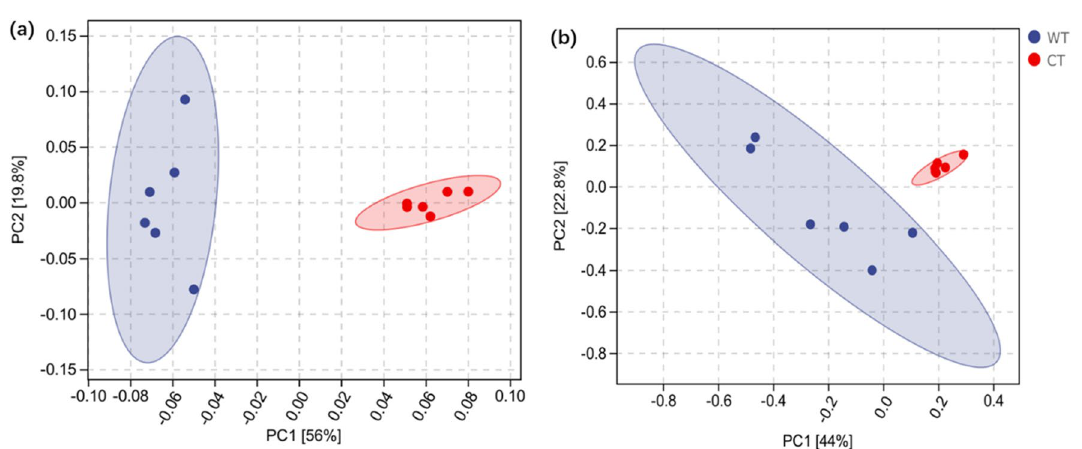
Figure 4. Beta diversity analysis of ( a ) bacteria and ( b ) fungi communities in in O. elatus rhizosphere soil from cultivated (CT) and wild (WT)conditions by using principal component analysis (PCA) based on Bray–Curtis